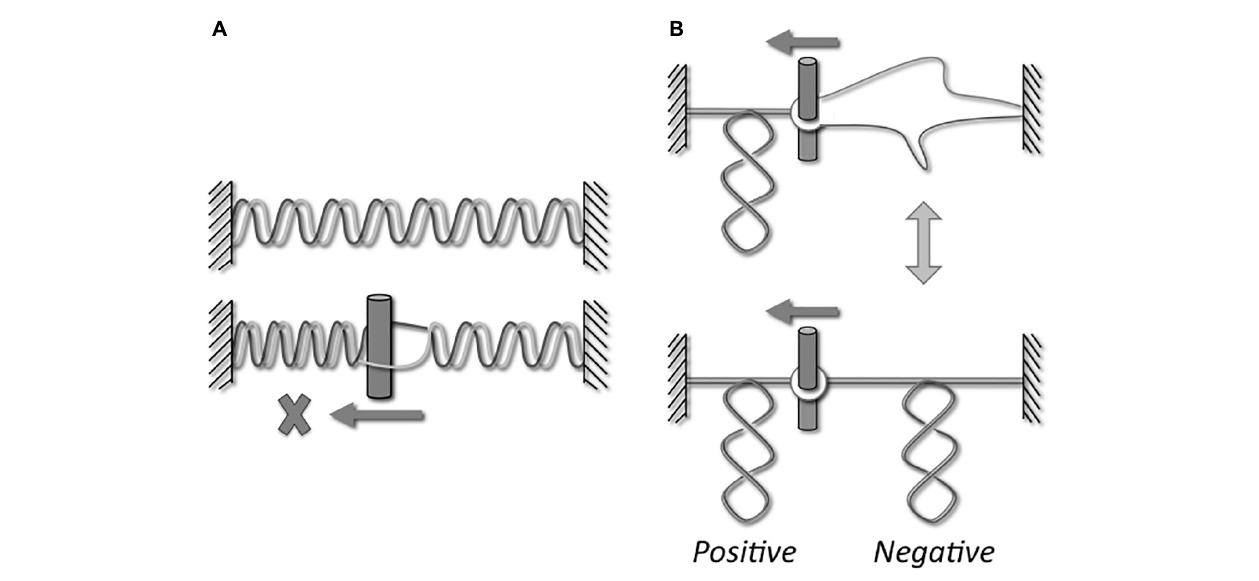
FIGURE 1 | Topological stresses during dynamic processes. If the DNA machineries do not rotate, their movements along the DNA induce an overwinding of the DNA ahead the machineries ( A , lower part). Considering the rigidity of the DNA, the torsional stresses cannot significantly modify the helical repeat and, consequently, it is the axis that forms supercoils. Indeed, a positive supercoiling appears ahead the machineries ( B , upper and lower parts). A melted DNA region can be formed behind the machineries ( A , lower part). However, if the temperature is lower than the DNA melting temperature, the DNA strands are reannealed to form a double helical structure. As a consequence of this underwinding, the DNA axis forms negative supercoils ( B , lower part). The equilibrium that exists between a melted form and negative supercoils form depends on the temperature and the DNA sequence. The consequence of this over- and underwinding is the arrest of the machineries or the loss of DNA recognition,